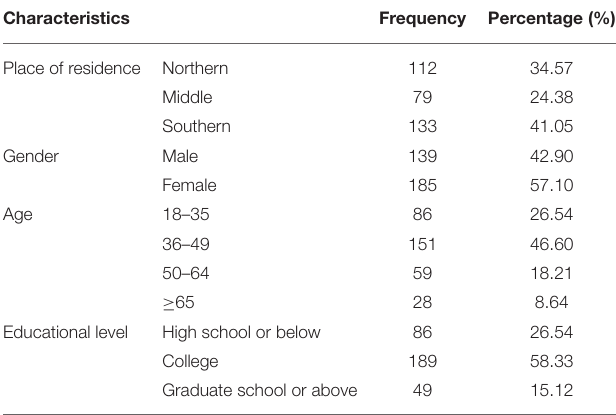
TABLE 4 | Demographic data of